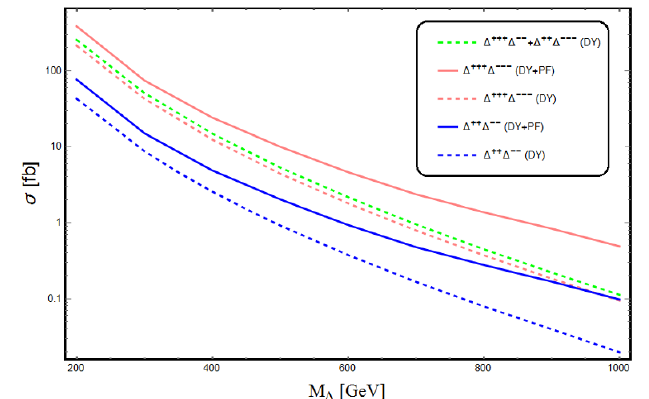
Figure 6 . Pair and associated production cross-sections of (cid:1) (cid:6)(cid:6)(cid:6) and (cid:1) (cid:6)(cid:6) at the 13 TeV LHC. Red solid (dashed) line is for (cid:1) (cid:6)(cid:6)(cid:6) pair production cross section via both DY and photon fusion processes (only DY process) and blue solid (dashed) line is for (cid:1) (cid:6)(cid:6) pair production cross section via both DY and photon fusion processes (only DY process). Green dotted line represents associated production cross section of (cid:1) (cid:6)(cid:6)(cid:6) and (cid:1) (cid:6)(cid:6) .